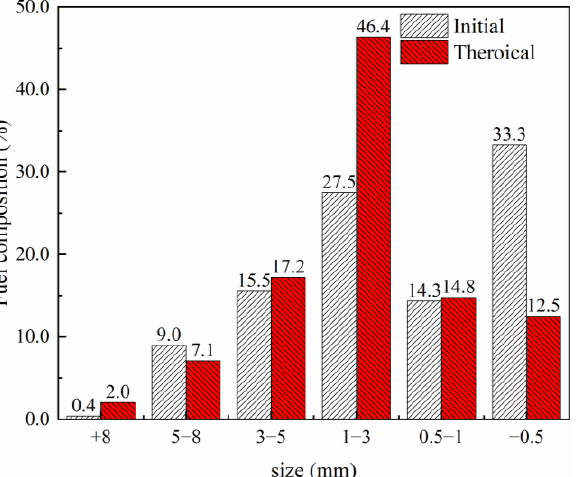
Figure 7. The comparison between the suitable fuel size composition and the initial fuel size composition.